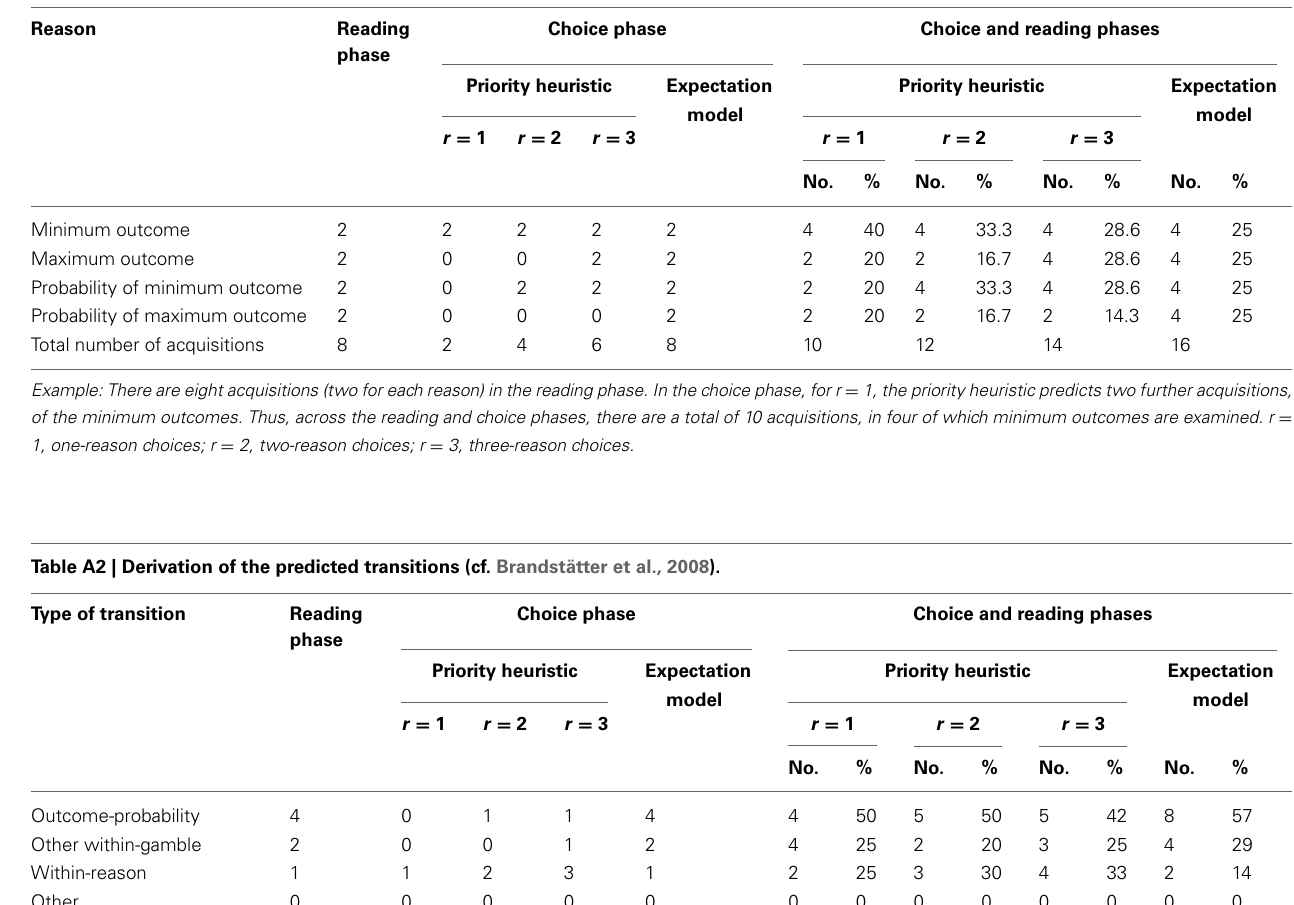
than according to the natural reading